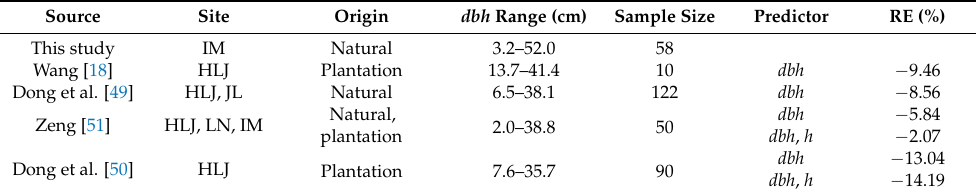
Comparison of some existing biomass equations for L. gmelinii distributed in northeastern China.